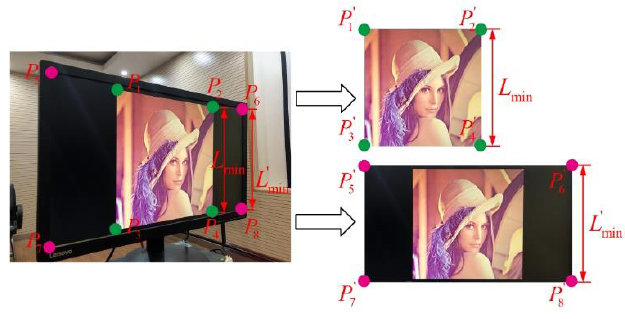
Figure 9. Schematic diagram of correction process.